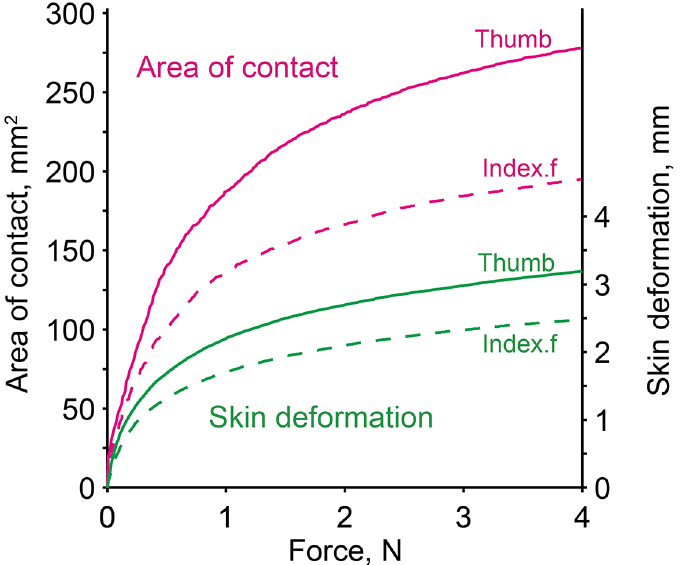
Fig 6. Mean finger-surface contact areas and finger pad skin deformation for the thumb and index finger for all subjects in relation to varied magnitude of grip force applied.